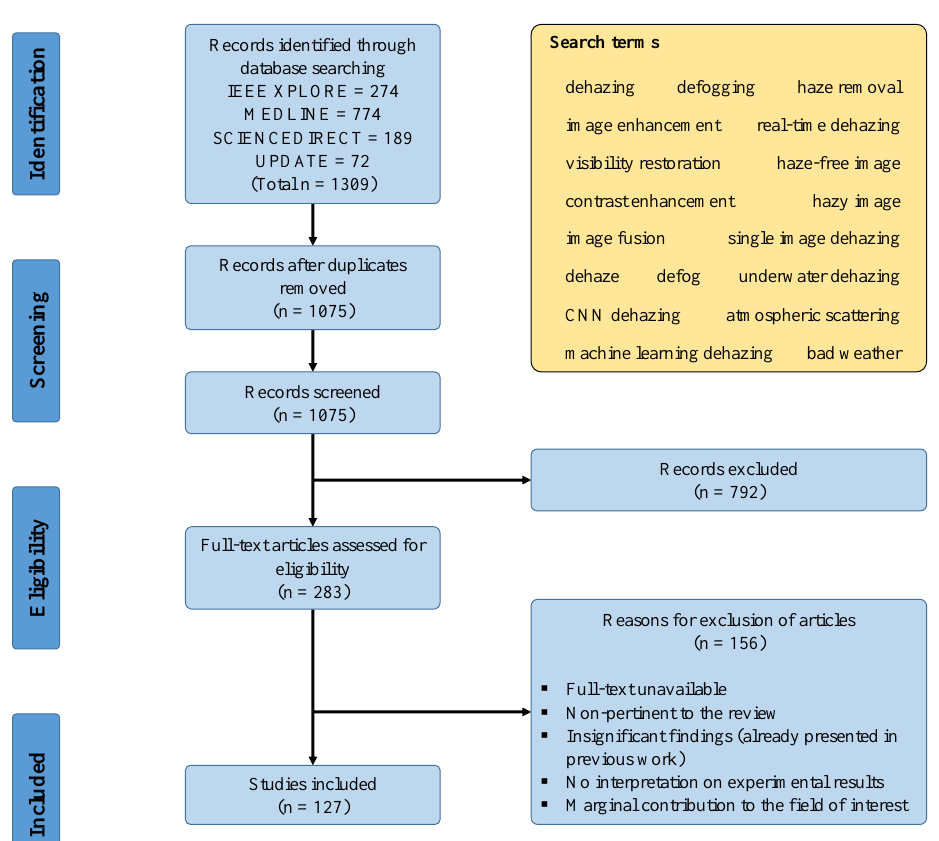
the sensor element to the object. Variables with the subscript k are pertinent to the sensor element k .